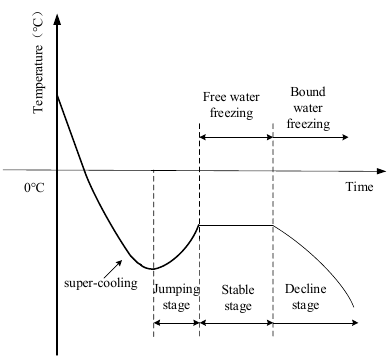
Figure 1. Typical cooling curve of the frozen soil. Quartz sand (hereinafter referred to as sand) material commonly used as the filling layer in freezing model tests was selected for the research. The saturated volume water content of the selected sand layer is 20% [23], and the other properties of the sand layer are reported in Table 1. NaCl was selected as the salt source. Considering that the average salinity of seawater is 3.5%, the saline solution with mass salinities (hereinafter referred